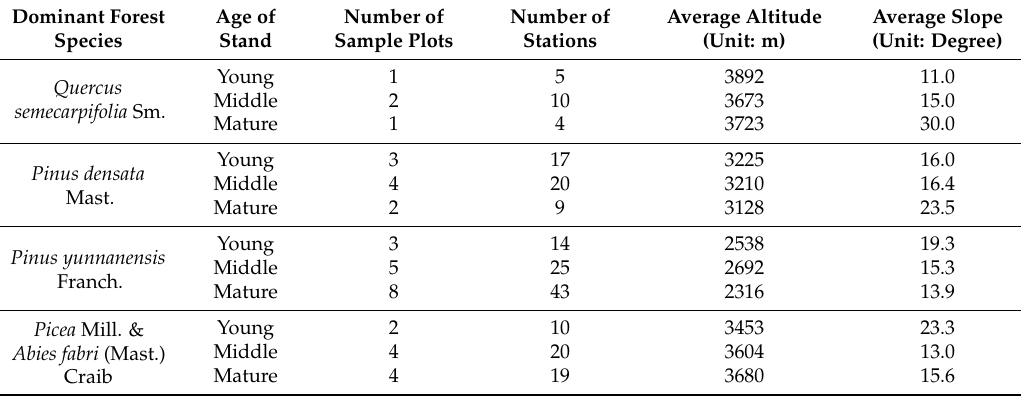
Table 2. Number of different types of forest sample plots in the